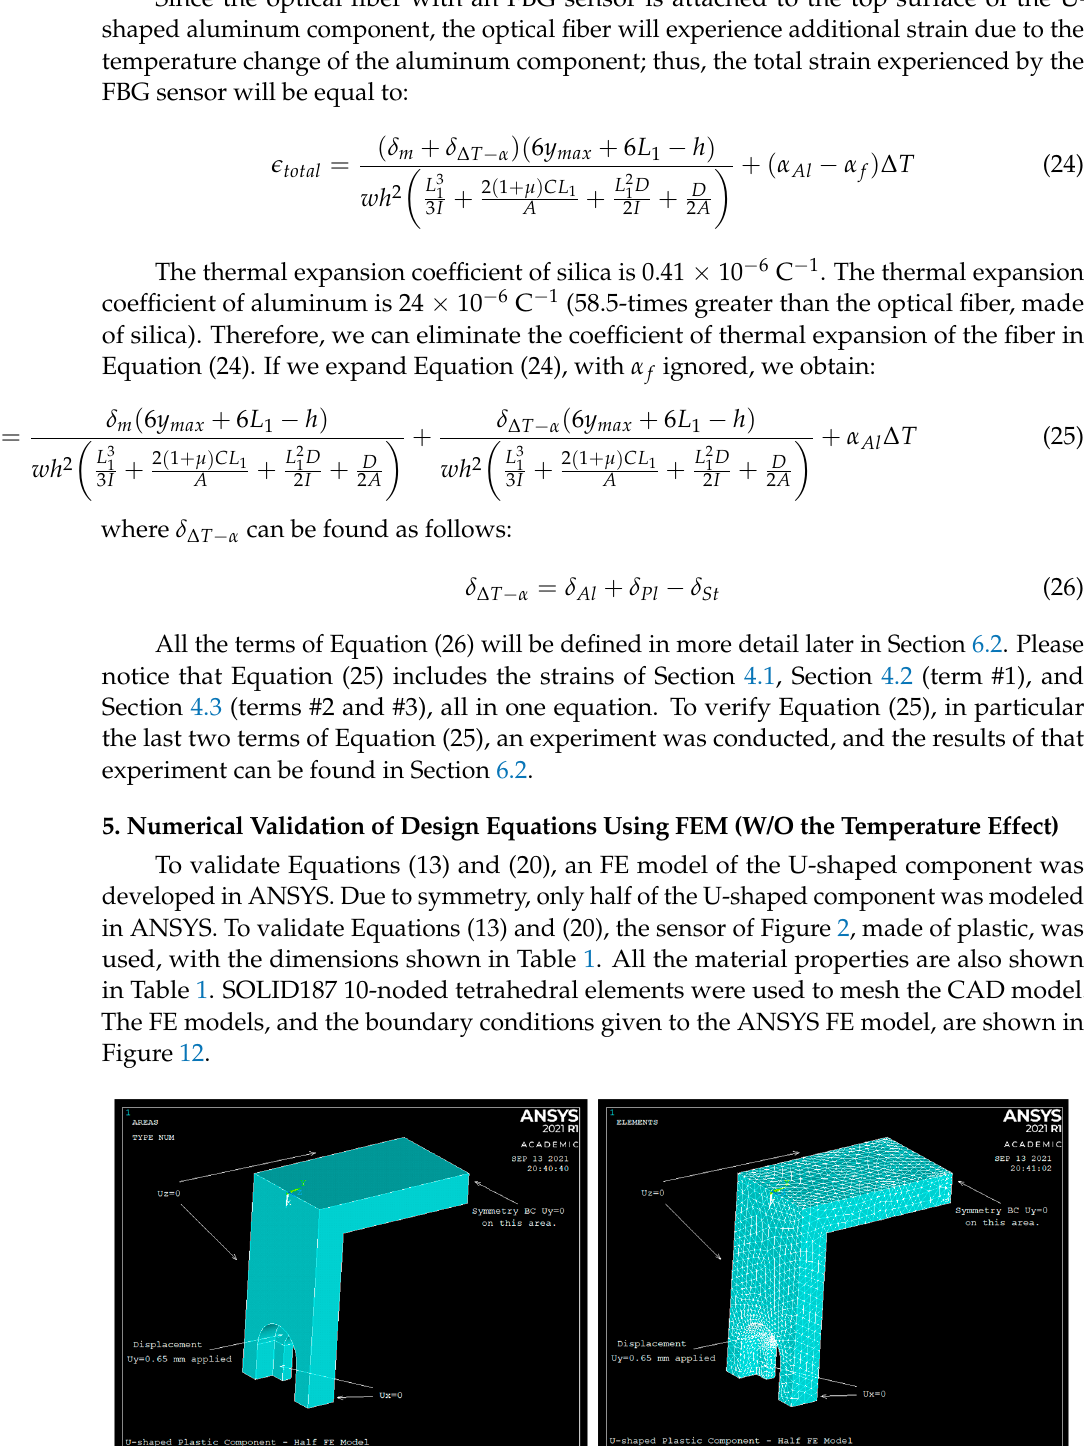
( b ) Geometric nonlinearity ON Figure 13. Tension strain ( ε y ) observed in ANSYS on the top surface of beam 2. To verify Equation (20), meaning to account for the effect of buckling/bending on the tension strain of the top surface of the U ‐ shaped plastic component, the geometric nonlin ‐ earity was turned ON in ANSYS. Figure 13b indicates that the strain at the middle of the top surface of beam 2 is 0.004306 (4306 με ). When the geometric nonlinearity is ON, Table 1 indicates that the strain calculated by Equation (20) is 3.1% off from the ANSYS strain results. The ANSYS tension strain results correlate very well with the analytical results.